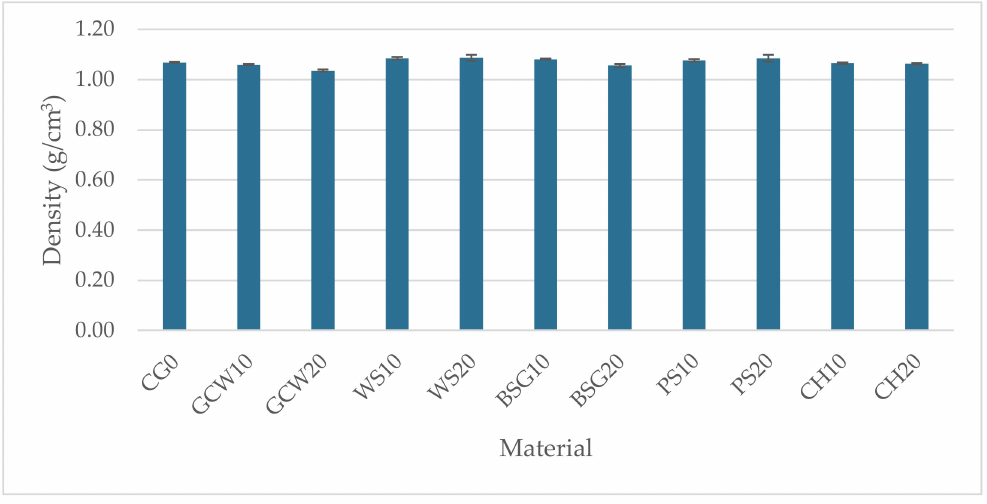
Figure 6. Materials’ density (g/cm 3 ).